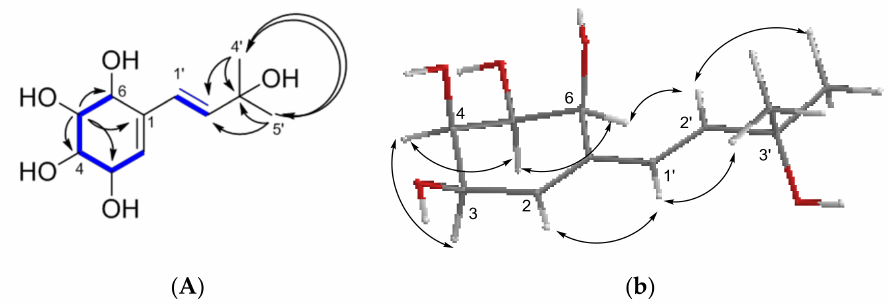
Figure 3. ( A ) COSY (in boldface), HMBC (black arrows) and ( B ) NOESY (black arrows) of